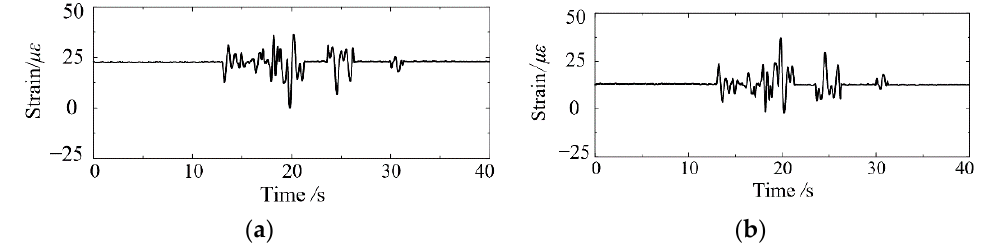
Figure 12. Strain time history at point S1: ( a ) the left side of S1; ( b ) the right side of S1.